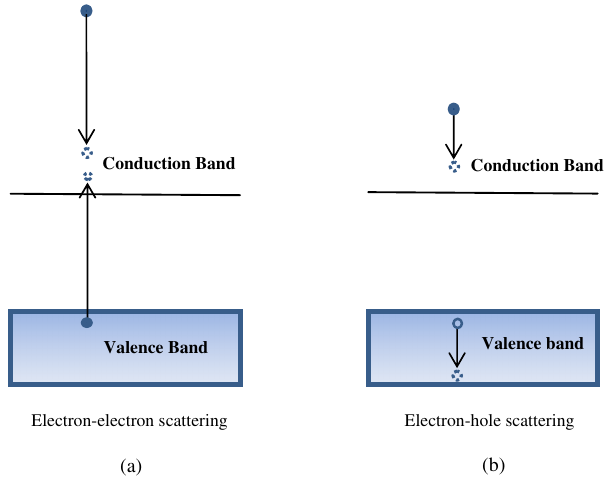
FIG. 8. Electron-electron scattering (a), and electron-hole scattering (b). The solid/ring circles are the initial states of electrons/holes respectively, and the dotted rings are their end states after